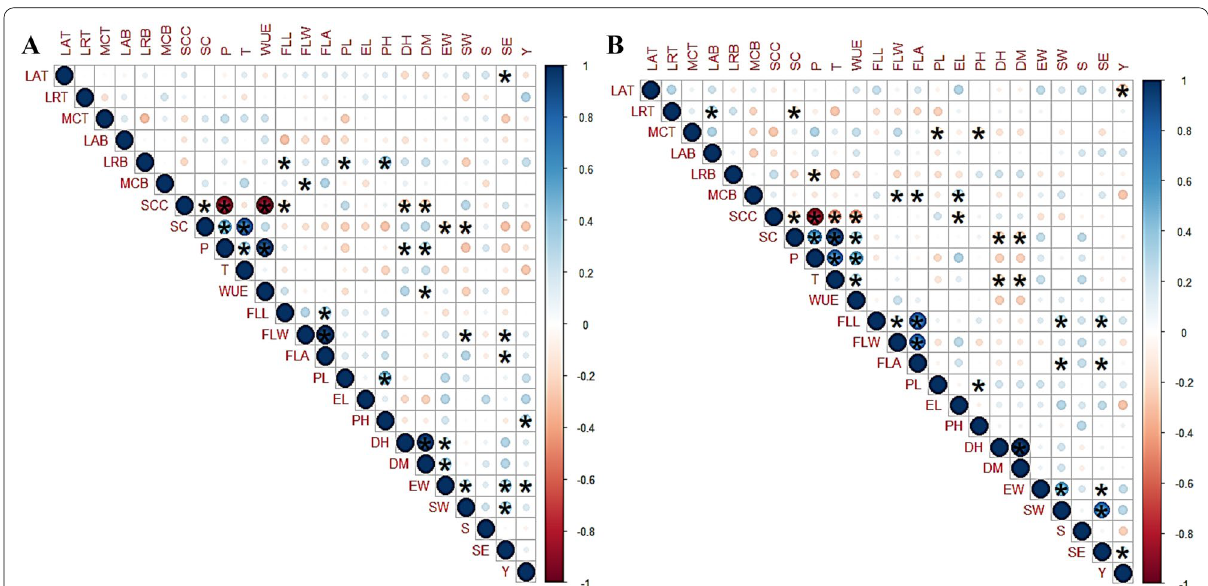
Fig. 7 Corplot of phenotypic correlation among leaf traits viz leaf rolling (LRT and LRB), leaf angle (LAT and LAB) at tillering (T) and booting (B), moisture capturing (MC), physiological parameters viz Stomatal conductance (SC), sub stomatal conductance (SCC), photosynthesis (P), transpiration (T) and water use efficiency (WUE), and yield parameters viz flag leaf length (FLL), width (FLW) and area (FLA), peduncle length (PL), ear length (EL), plant height (PH), days to heading (DH), days to maturity (DM), ear weight/spike (EW), seed weight/spike (SW), spikelets/spike (SS), no. of seed/spike (SE) and yield/plot (Y) of 44 wheat genotypes under normal ( A ) and drought ( B ) field conditions. The blue shade shows a positive correlation and the pink shade shows a negative correlation. The size of the circle shows how traits are associated with each other. More size means strong association. * indicates significant (P < 0.05) and without sign (*) indicates non‑significant (P ≥